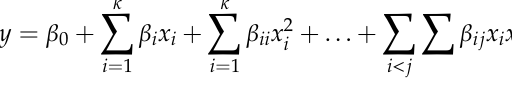
Figure 4. General model of a process or a system [37].